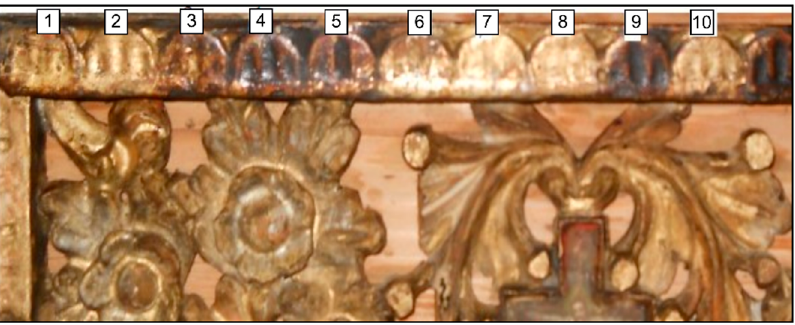
Figure 12. Washing tests for the gold gilded wood carving and embroidery with mono or mixed organic solvent solutions (E1–E10).